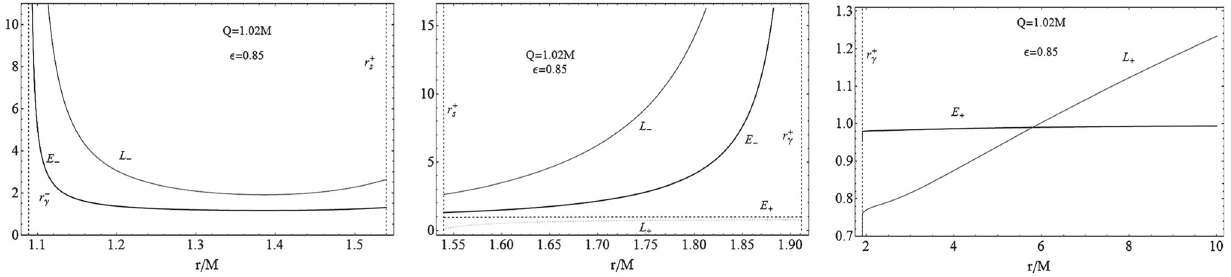
√ Fig. 10 Class : M < Q ≤ 5 /( 2 6 ) M and (cid:2) l < (cid:2) < (cid:9) (cid:9) (cid:2) + . Param- ( gray curves ) and energy E = E + ( black curves ) in r − γ < r < r + s ( left eter choice is as follows: Q = 1 . 02 M and (cid:2) = 0 . 85. Then (cid:2) l = plot ); L = L ± in r + s ≤ r < r + γ ( center plot ); and L = L − in r ≥ r + γ 0 . 806548, (cid:9)(cid:9) (cid:2) + = 0 . 914942, r + s = 1 . 53979 M , r − γ = 1 . 08866 M , and ( right plot r + γ = 1 . 91134 M .Circularorbitsexistwithangularmomentum L = L +